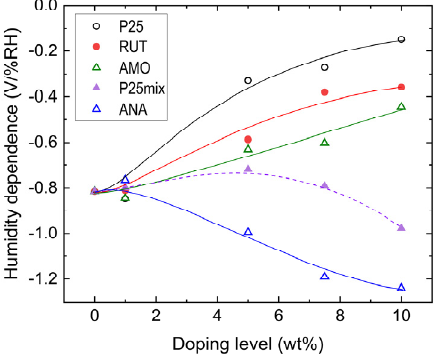
Figure 6. Plot of humidity dependence against doping level for the PES films doped with RUT, ANA, AMO, P25, and P25mix nanoparticles.